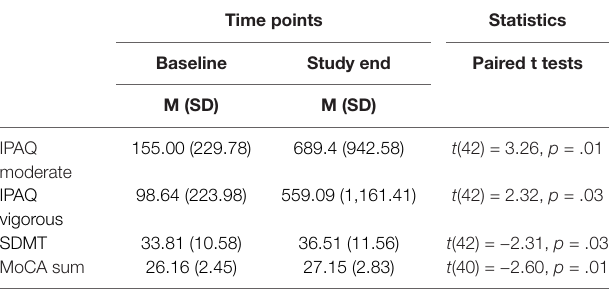
TABLE 3 | Descriptive and inferential statistical overview of values for subjective physical activity and cognitive performance at baseline and at the study